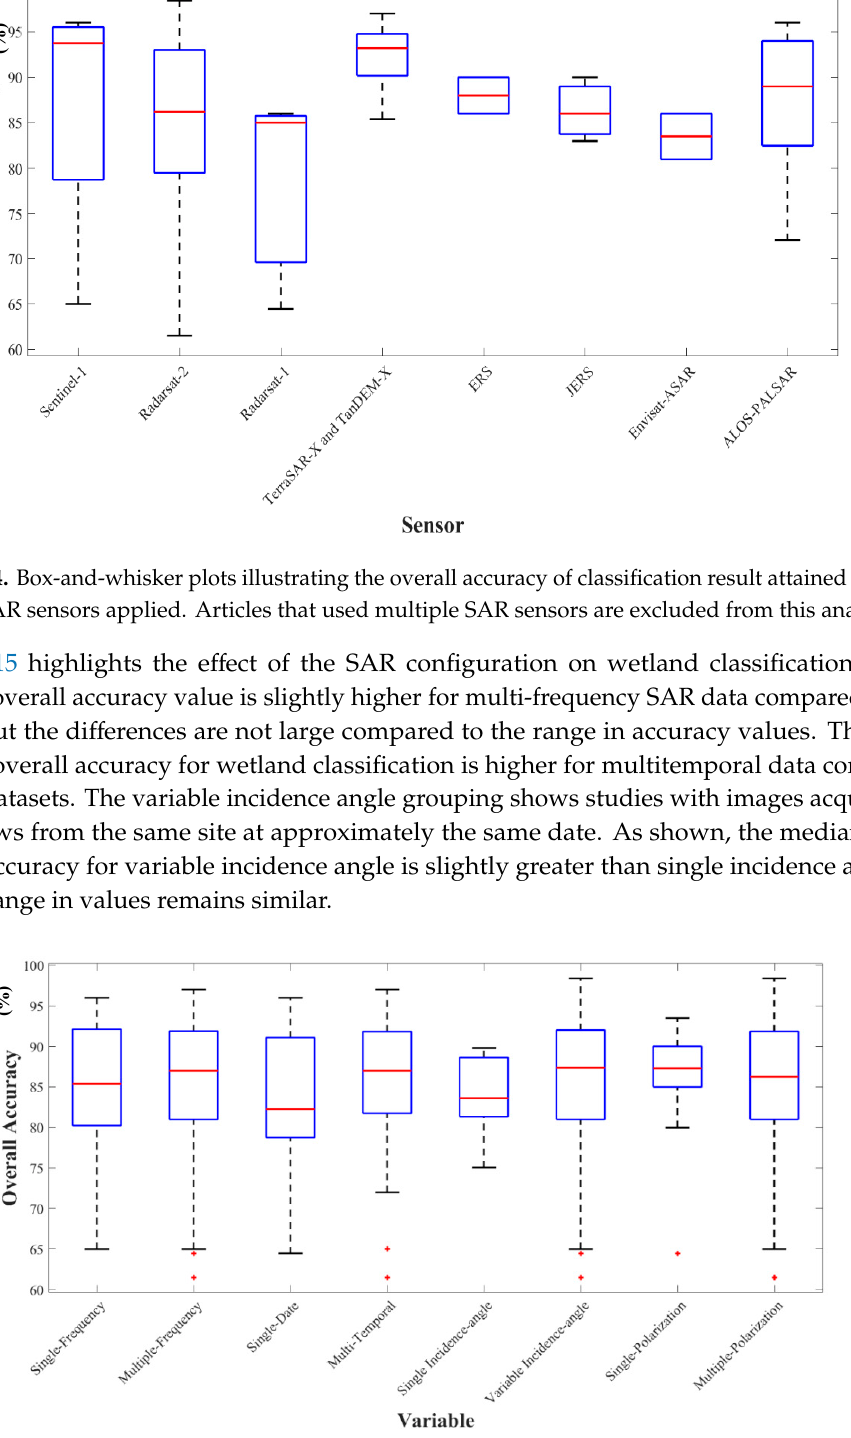
Figure 15. Box-and-whisker plots illustrating the e ff ect of applying di ff erent SAR configurations on overall